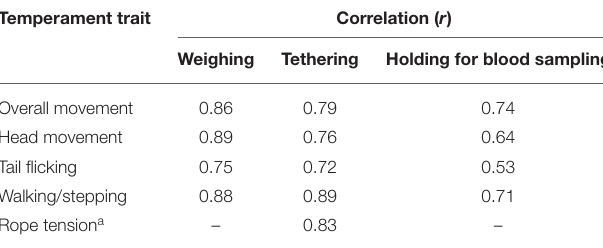
TABLE 3 | Correlation ( r ) of visual analog scale (VAS) between two observers. Temperament trait